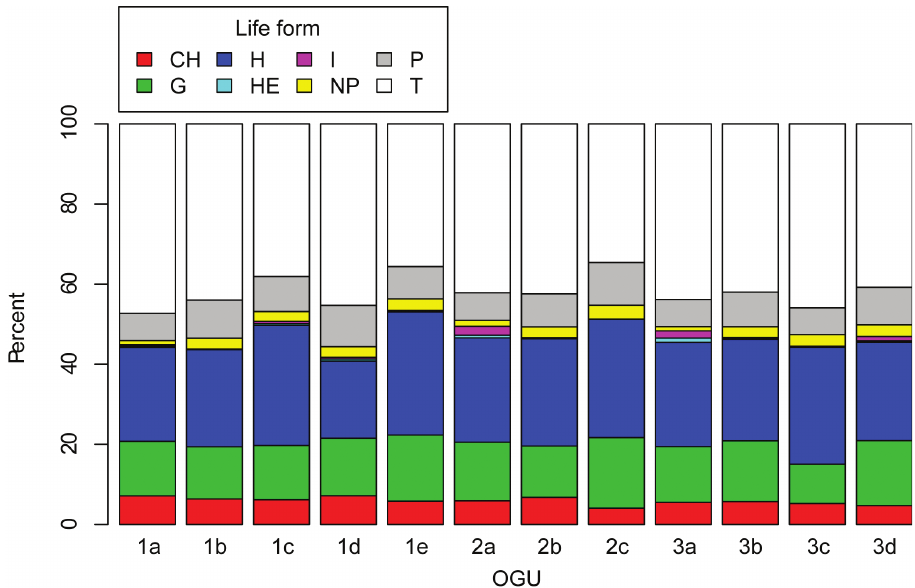
Figure 2. Life form spectra for each Operational Geographic Unit. CH = Chamaephytes, G = Geophy- tes, H = Hemicryptophytes, HE = Helophytes, I = Idrophytes, NP = Nanophanerophytes, P = Phanero- phytes, T =